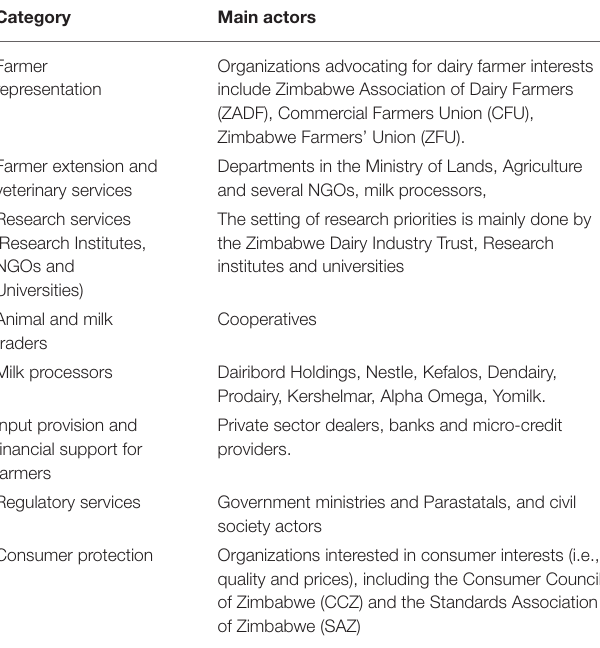
TABLE 1 | Summary of Zimbabwe milk value chain